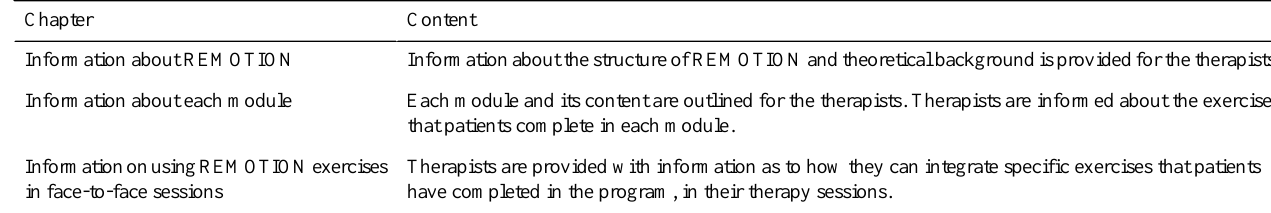
Table 2. Information provided to